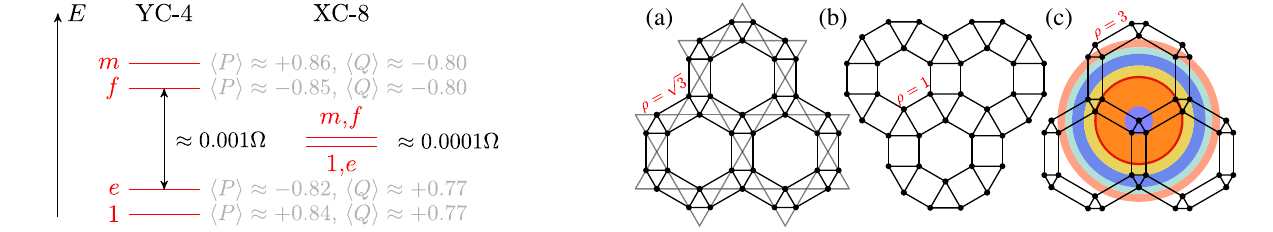
8. Topological ground state degeneracy. In the topological phase, we obtain the 1 and e ground states from DMRG with random initial states. The m and f states are obtained by starting from fixed-point resonating dimer states and subsequently applying imaginary time evolution. The energies shown are for δ = Ω ¼ 1 . 7 . In light gray, we also show the eigenvalues of the P and Q loop operators around the circumference (for YC-4); the four ground states are characterized by the signs of these